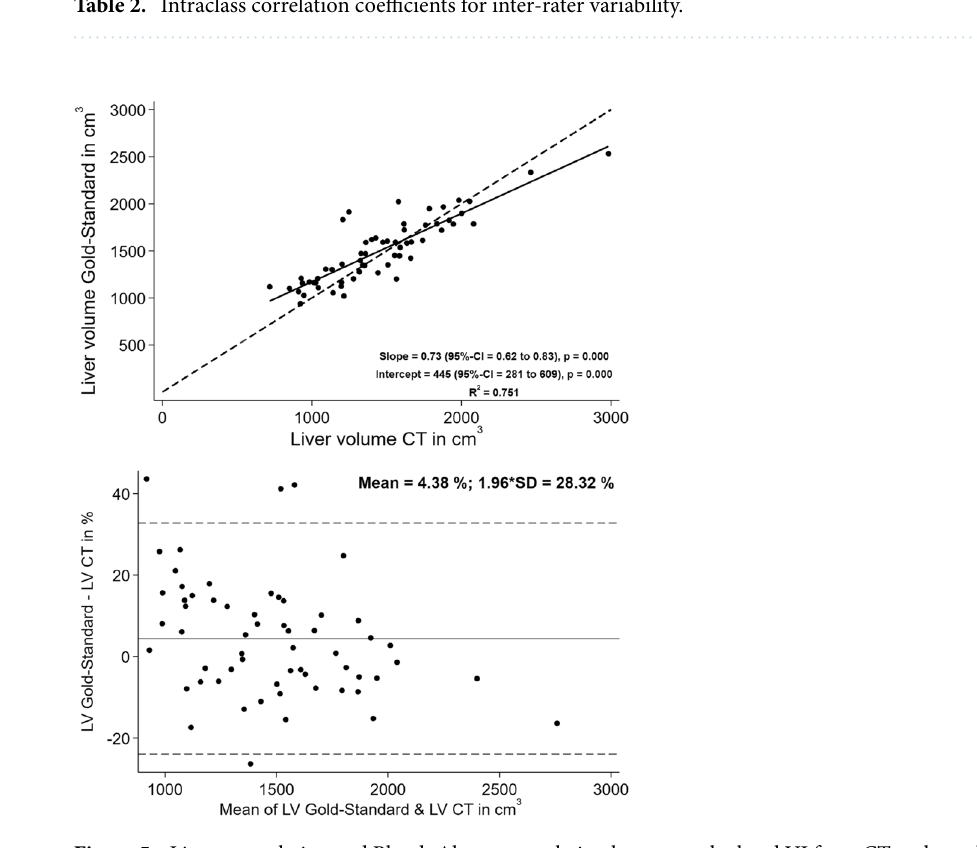
Figure 5. Linear correlation and Bland–Altman correlation between calculated VI from CT and true liver